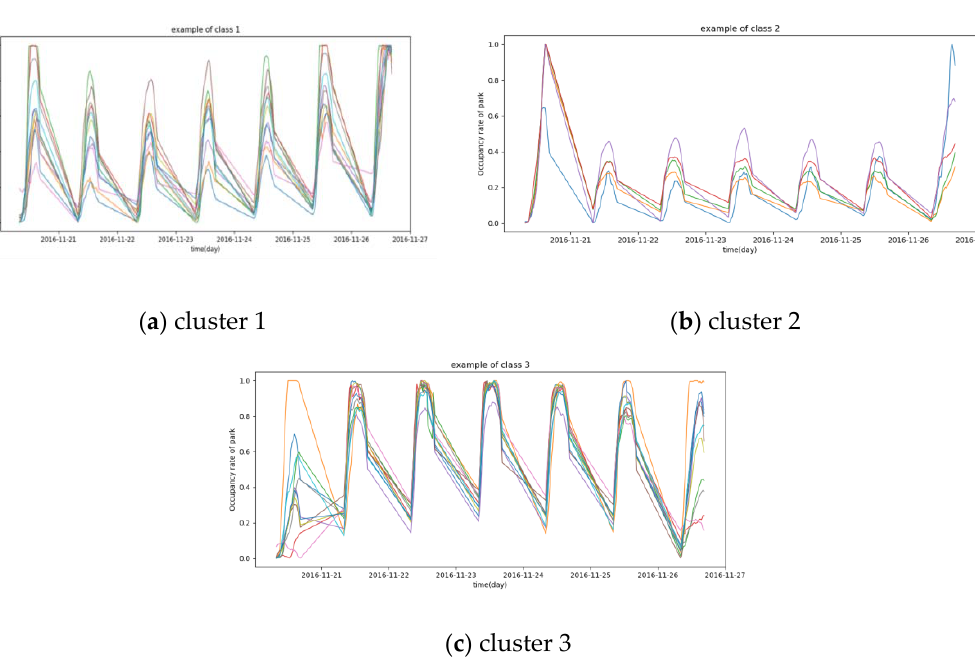
Figure 5. Results of clustering on data2. Figure 5 contains three graphs which were listed by clusters: (a) cluster 1, (b) cluster 2, (c) cluster 3.